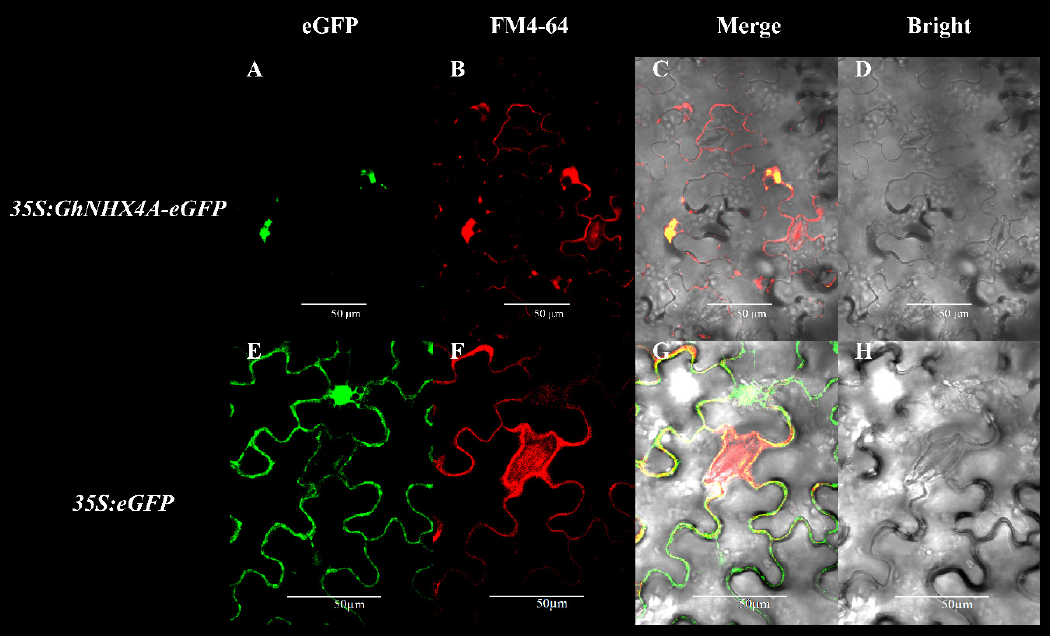
Figure 6. Subcellular localization of GhNHX4A in tobacco leaves. ( A – D ) 35S:GhNHX4A-eGFP , eGFP- tagged GhNHX4A; ( E – H ) 35S:eGFP , control; ( A , E ) Green fluorescence image; ( B , F ) Red